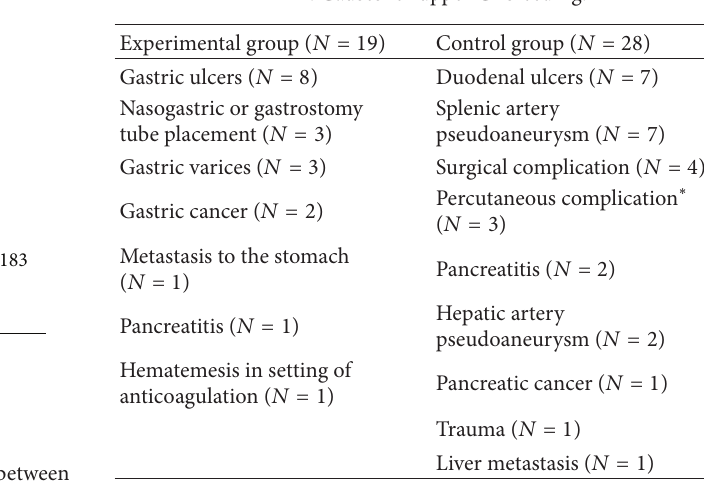
Table 2: Causes for upper GI